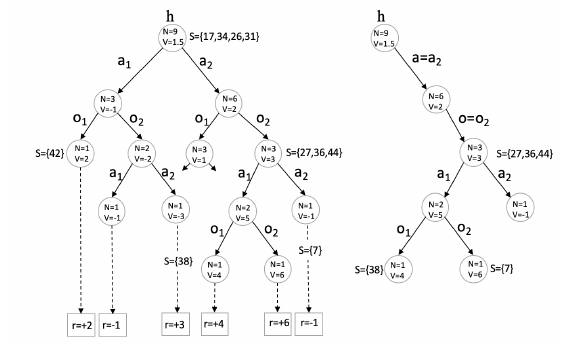
Figure 5. An illustration of POMCP in an environment with 2 actions, 2 observations, 50 states, and no intermediate rewards. The agent constructs a search tree from multiple simulations and evaluates each history by its mean return (left). The agent uses the search tree to select a real action a and observes a real observation o (middle)